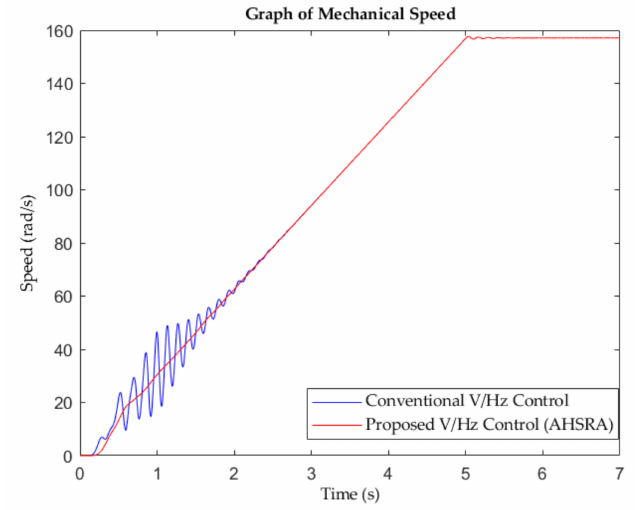
Figure 11. Mechanical speed—AHSRA (red) vs. conventional V/Hz (blue).